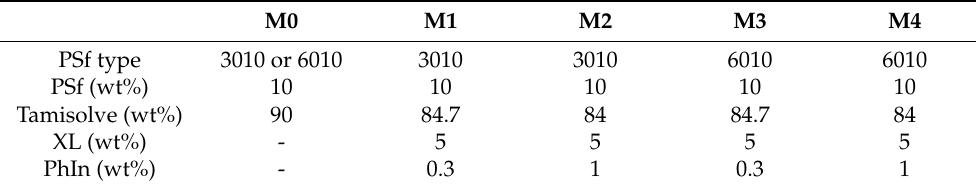
Table 1. Composition of the reference (M0) and UV-cured PSf membranes (M1–M4). M0 M1